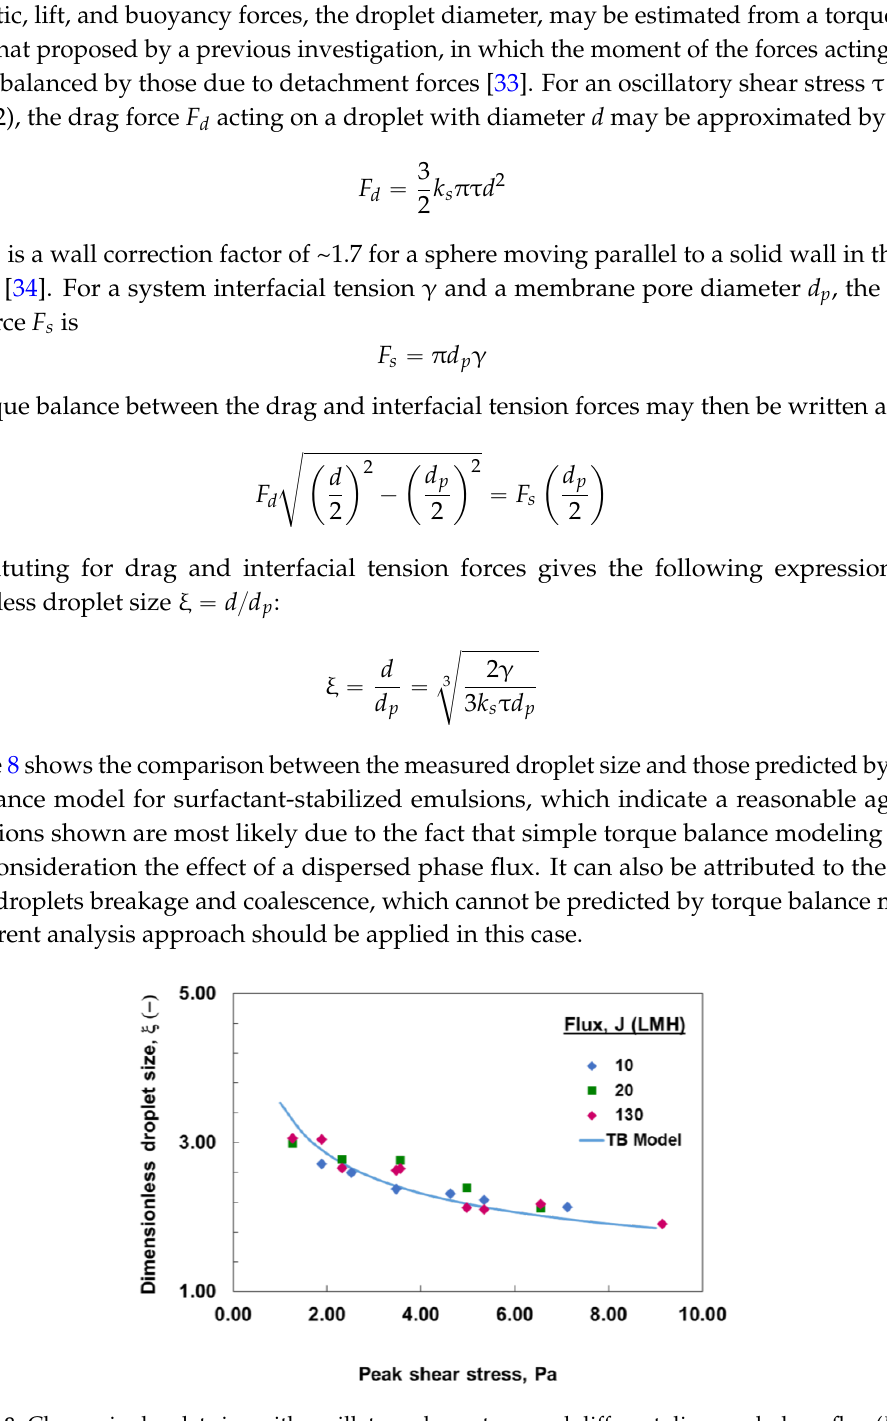
Figure 8. Change in droplet size with oscillatory shear stress and different dispersed phase flux ( J ) for surfactant-stabilized emulsions. Comparison between measured (markers) and torque balance (TB) model predictions (solid line).